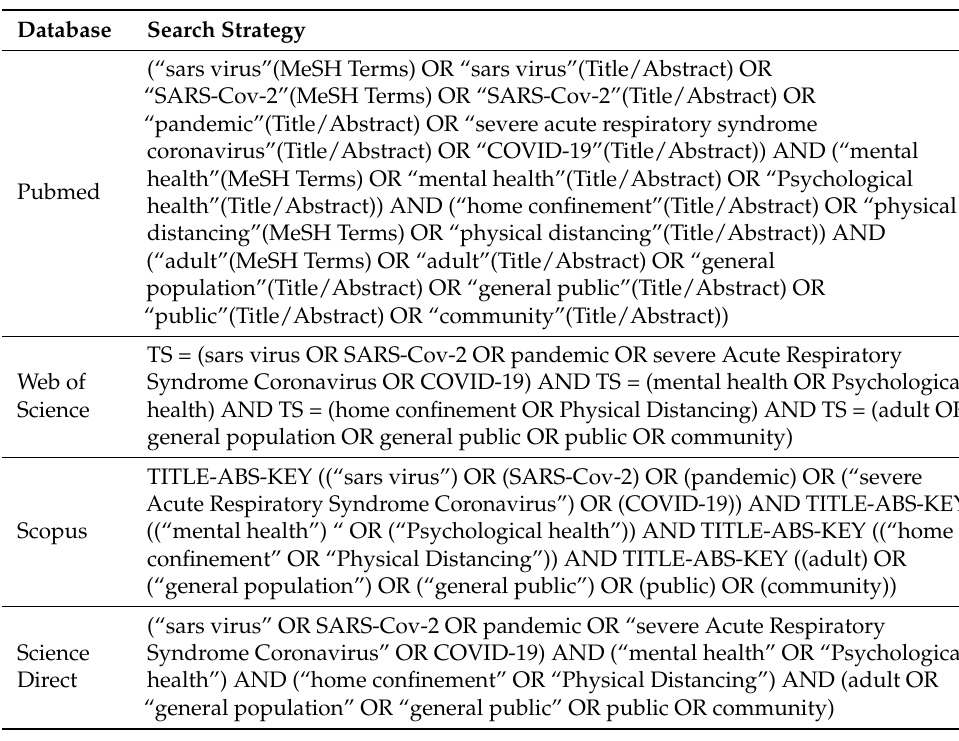
Table 2. Search strategy used, adapted to each of the